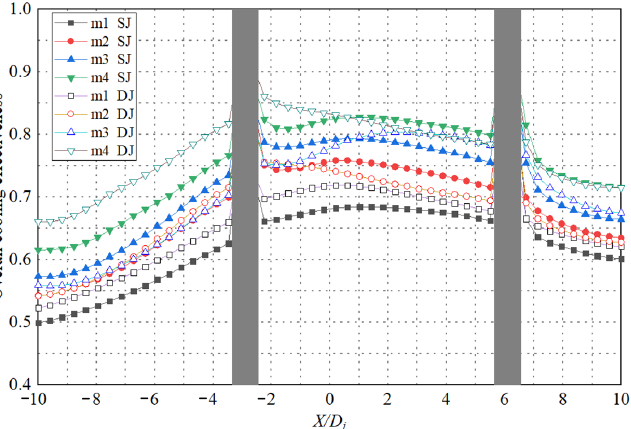
Figure 9. Overall cooling effectiveness along streamwise midline of outer surface in different mass flow rates.